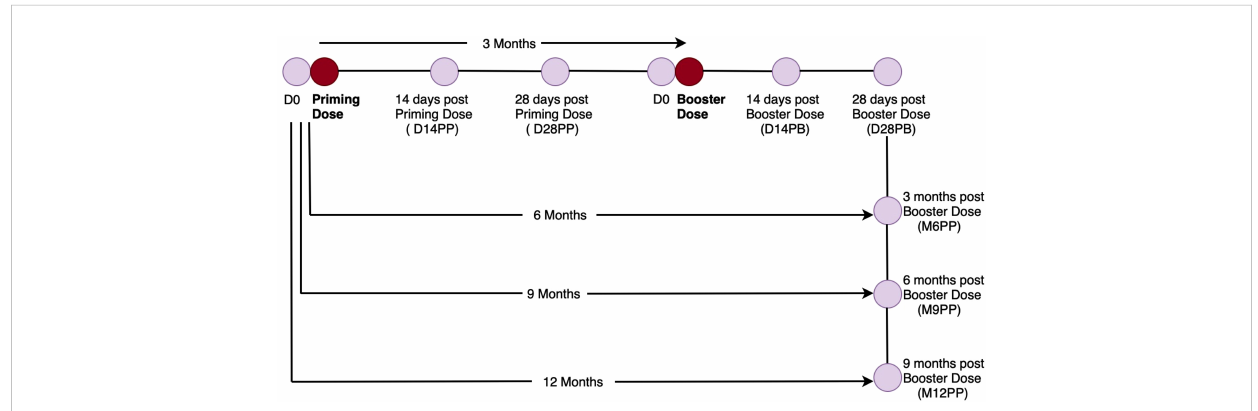
FIGURE 1 Graphical Illustration of the Cohort Time Points and Specimen Collection. Figure 1 summarises the vaccination and specimen collection time points, beginning shortly before priming and continuing for up to one year after the initial